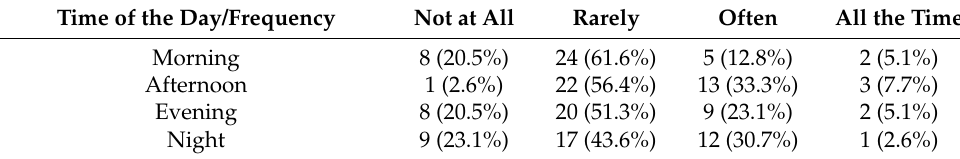
Table 2. Occurrence of pruritus during different times of the day.